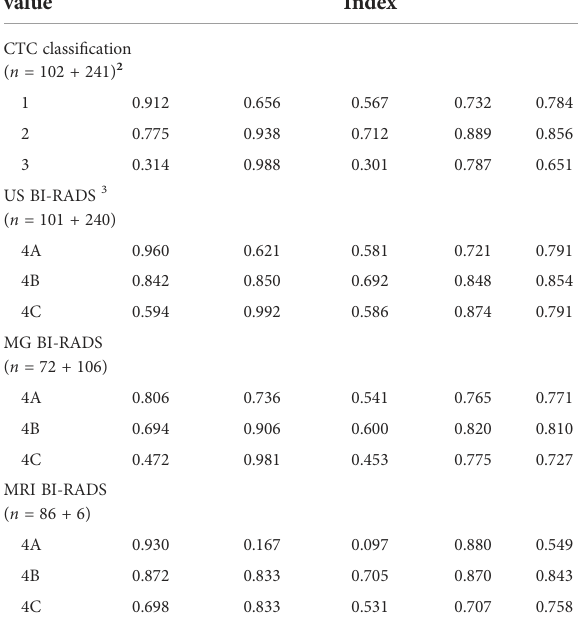
3 Imaging BI-RADS scores indicate different levels of likelihood of breast cancer: 4A, low (2% < likelihood ≤ 10%); 4B, moderate (10% < likelihood ≤ 50%); and 4C, high (50% < likelihood ≤ 95%). CTCs, circulating tumor cells; BI-RADS, breast imaging-reporting and data system; BC, breast cancer; AUC, area under receiver operating characteristic curve; n, number of participants(BCpatients+negativecontrols);US,ultrasonography;MG,mammography; MRI, magnetic resonance